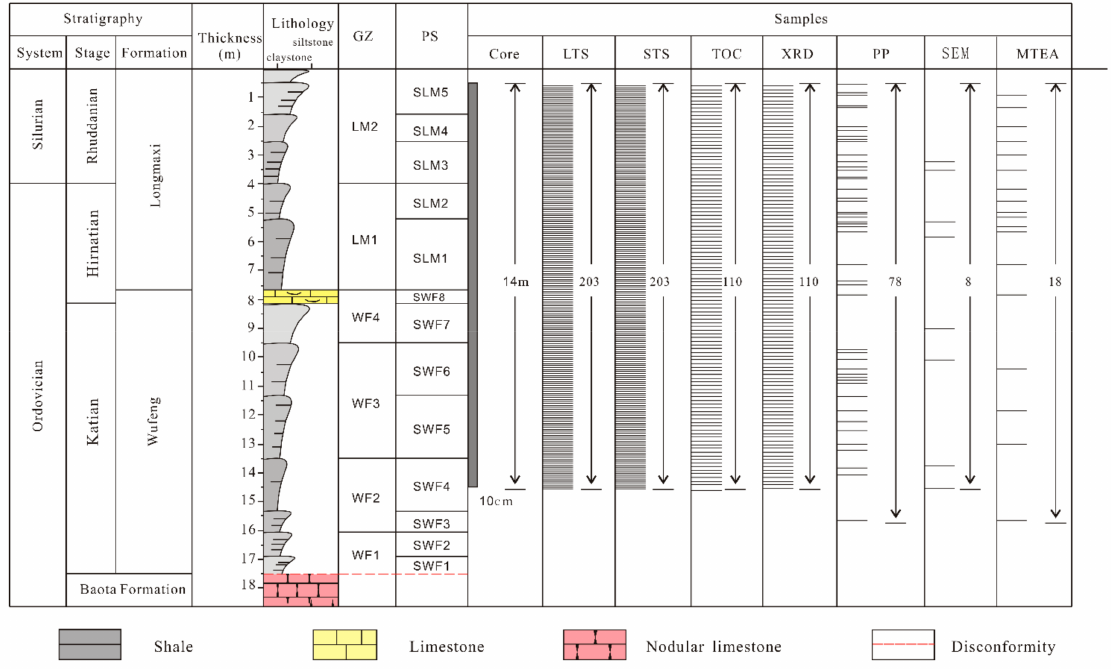
Figure 3. Sampling positions from the Wufeng–Longmaxi shale in the Shuanghe outcrop in Changn- ing County in the Sichuan Basin of southwestern China. The large thin sections (LTS) with a width